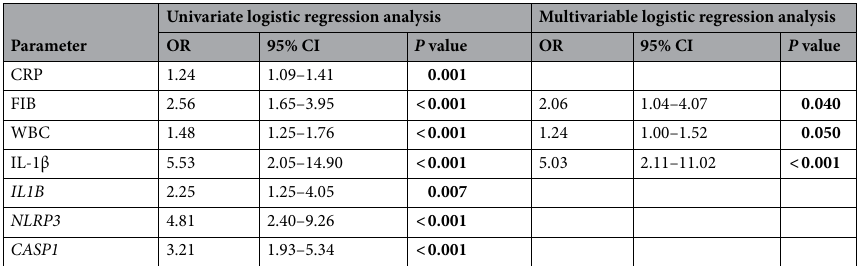
Table 2. Univariate and multivariable logistic regression analyses of common inflammatory parameters, plasma IL-1β and gene expression of IL1B , NLRP3 and CASP1 . Significant values are in bold. CRP C-reactive protein, FIB fibrinogen, WBC white blood cells, IL-1β interleukin-1beta, IL1B interleukin-1beta gene, NLRP3 nucleotide-binding oligomerization domain-like receptor family pyrin domain-containing 3 gene, CASP1 caspase-1 gene, OR odds ratio, CI confidence